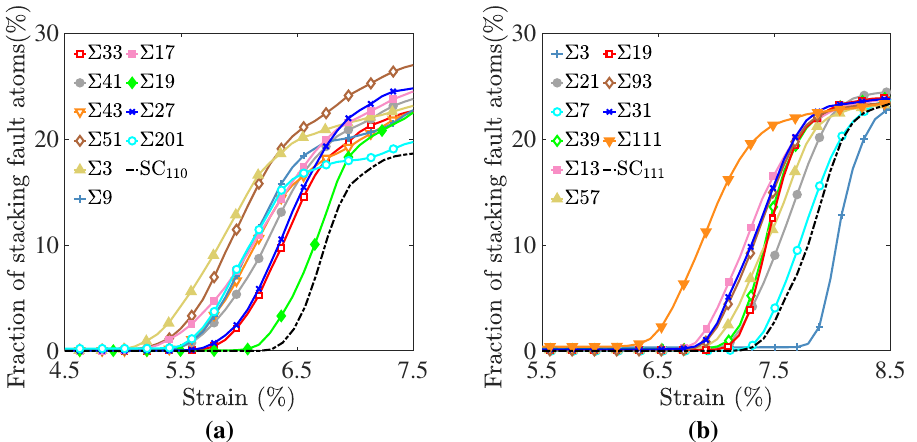
Figure 8. Evolution of the fraction of stacking fault atoms with respect to the total in each system as a function of tensile strain for bicrystal systems with (a) [110] and (b) [111] loading axis. Stacking fault atoms were identified using the PTM algorithm 63